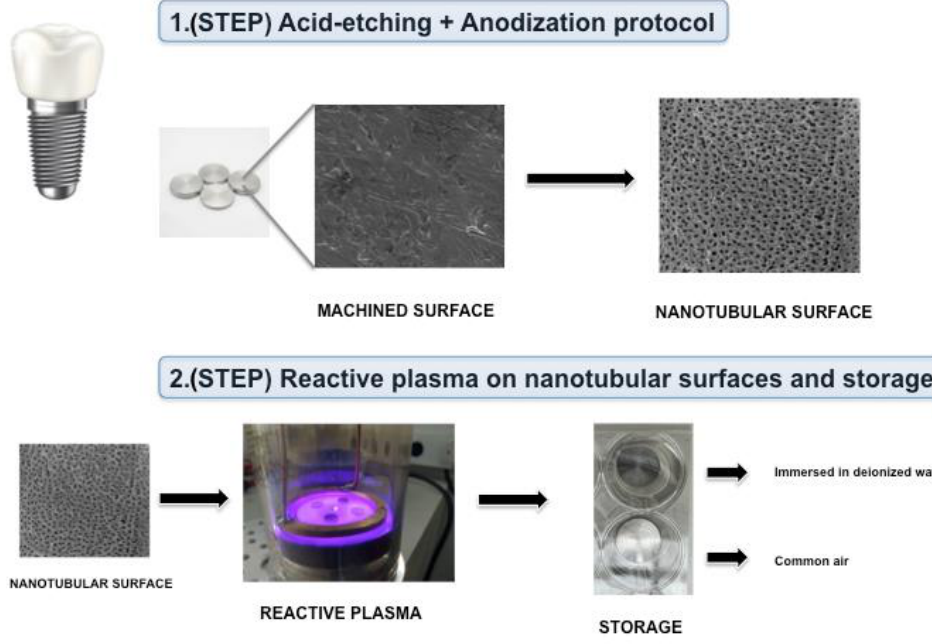
Figure 1. Scheme showing the methodological steps to achieve the hydrophilic nanotubular surfaces and methods for storage of disks. 1.(STEP)—Titanium disks with machined surfaces were treated using an anodization process in order to achieve nanotopography. 2.(STEP)—Nanotubular surfaces were submitted to reactive plasma application and directly stored in sterilized culture plates with DI water or common air.